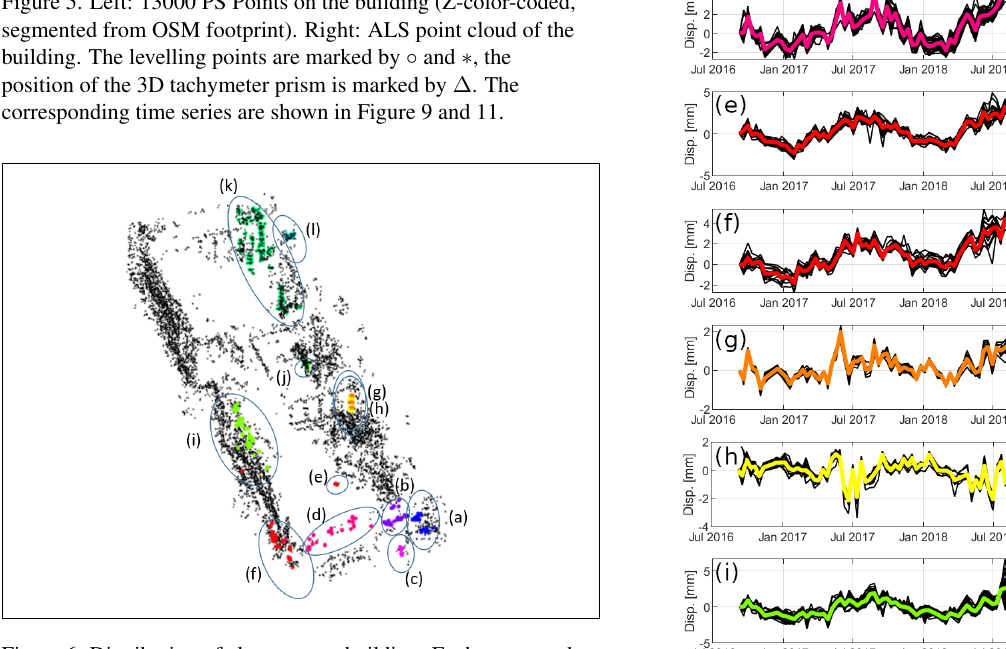
Figure 6. Distribution of clusters on a building. Each group and colour indicates a different cluster. The related time series are shown in Figure 8.